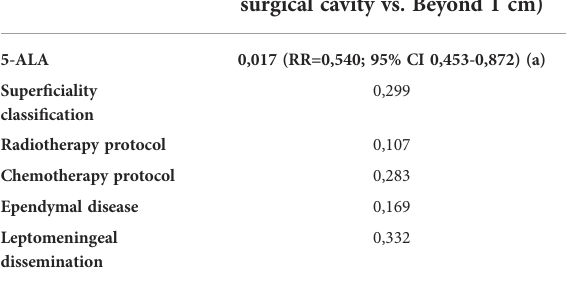
TABLE 4 Multivariate analysis.